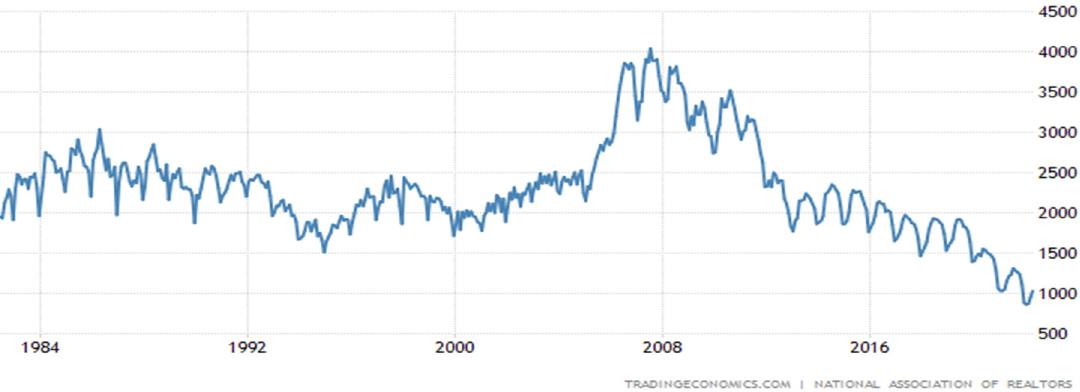
Figure 12. Total Housing Inventory (number of single-family and condos units available for